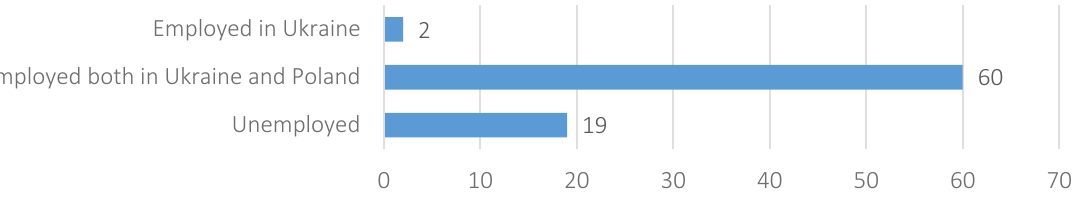
Figure 4. Distribution of scholars by their employment in